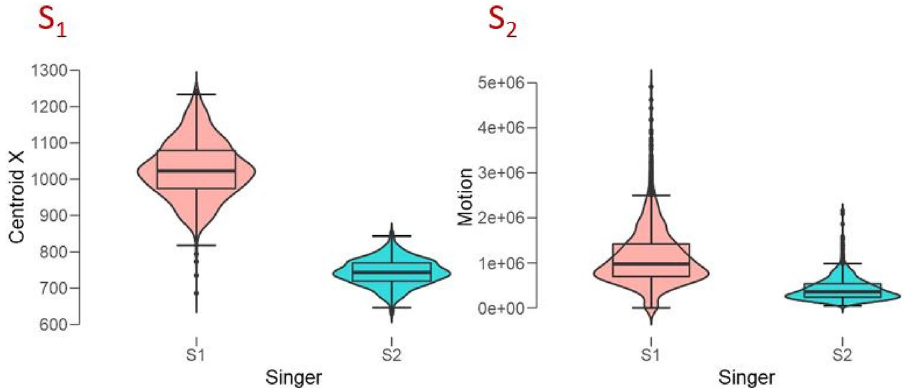
Figure 2. Experiment 1. Violin boxplots of motion captured from the videos of each singer (S 1 , S 2 ) and for the two strongest differences (Left: centroid X; Right; global motion).